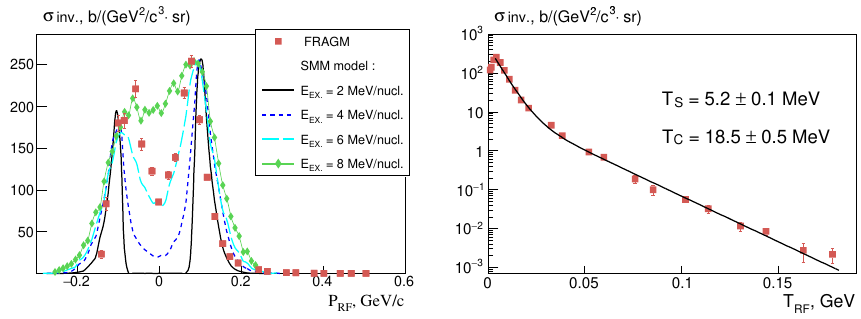
Figure 3. Two di ff erent methods to estimate the excitation energy on proton fragment spectra: the left plot shows the comparison between our experimental data and predictions of the SMM model, the right one demonstrates the invariant cross section fitted by a sum of two